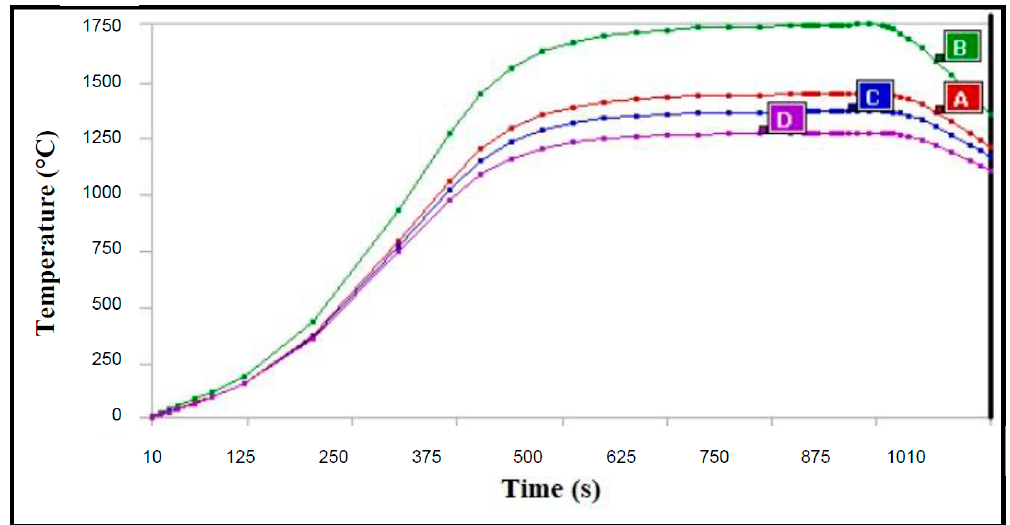
Figure 17. Temperature profile of a 1 cm thick C/C tile during re-entry phase. The profile is reported at four fixed heights of the C/C layer, from the upper exposed surface (probe B) down to the substrate (probe D), probes A and C representing intermediate points.